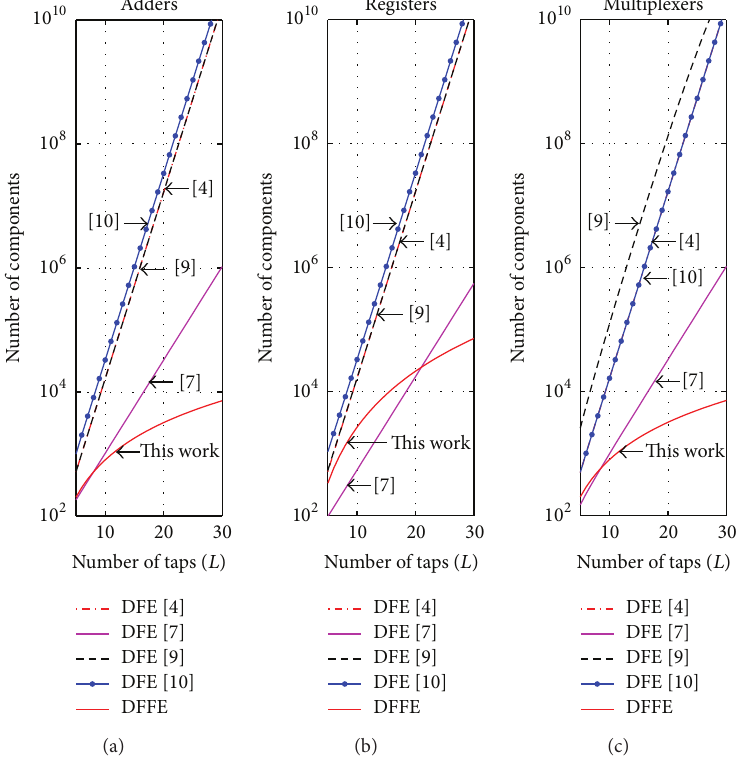
Figure 7: Number of adders, registers, and 2-to-1 multiplexers versus the number of feedback taps 𝐿 , for the parallel DFFE with 𝑅 = 𝐿 + 1 and DFE architectures proposed in [4, 7, 9, 10]. Parallelization factor: 𝑃 = 16 . Modulation format: 2-PAM.